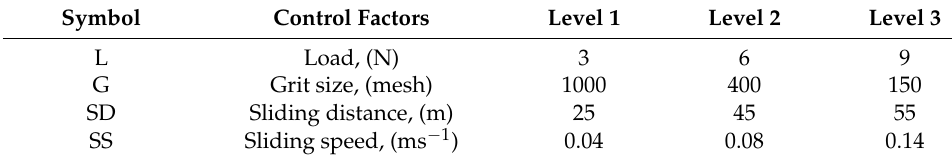
Table 2. Control factors and their